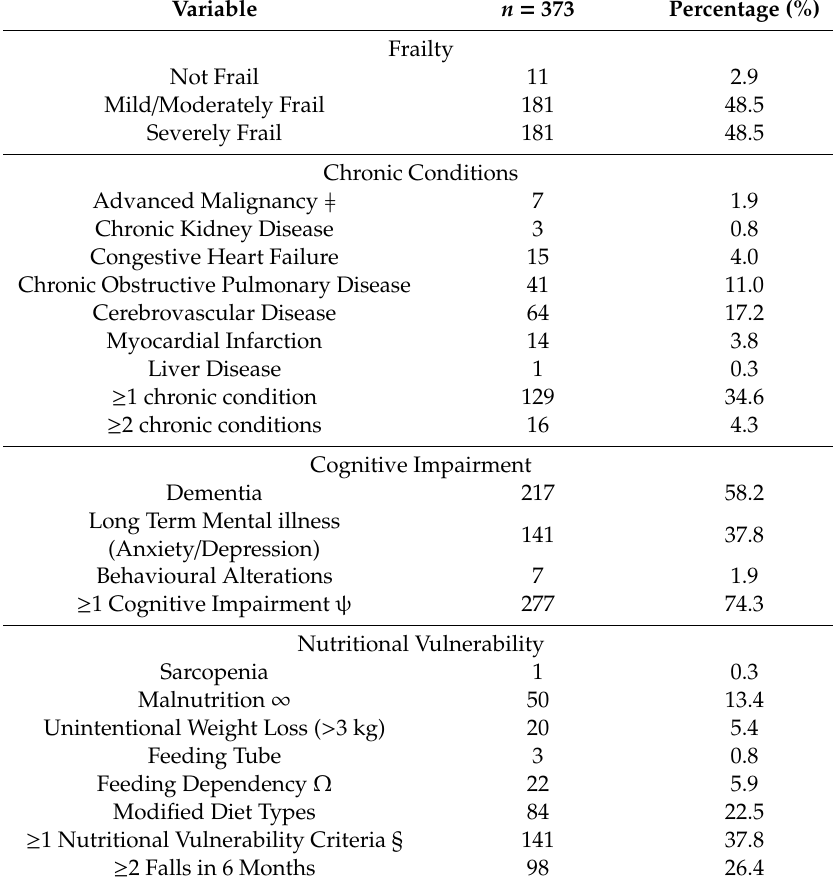
Table 1. Clinical characteristics of participants in 9 residential aged care